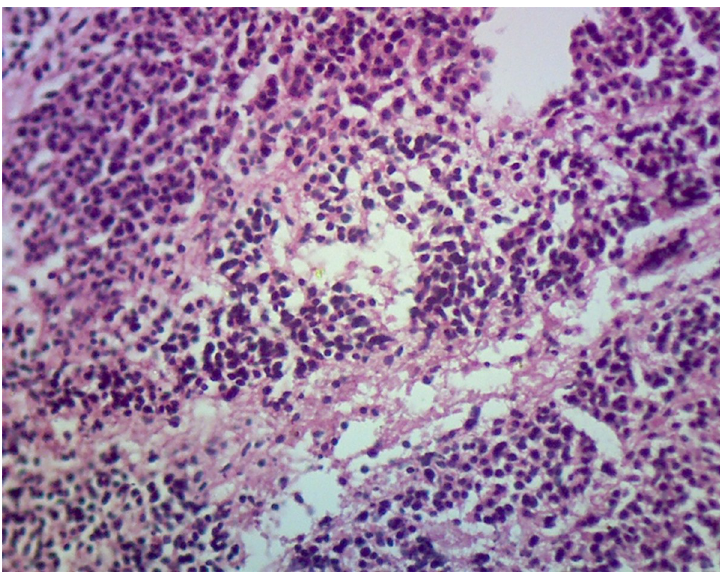
Fig 1. Histopathological section of the BF of chicken with infiltration of inflammatory cells, desquamation of surface epithelium (40X magnification, H&E staining).